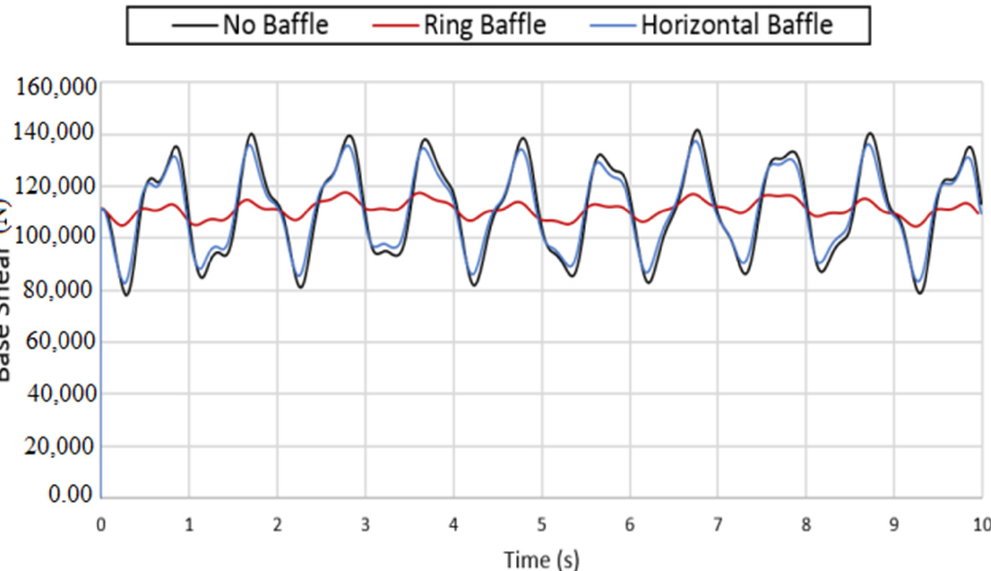
Figure 19. The maximum base shear (horizontal baffle, annular, and no baffle) in a flexible elevated storage tank.